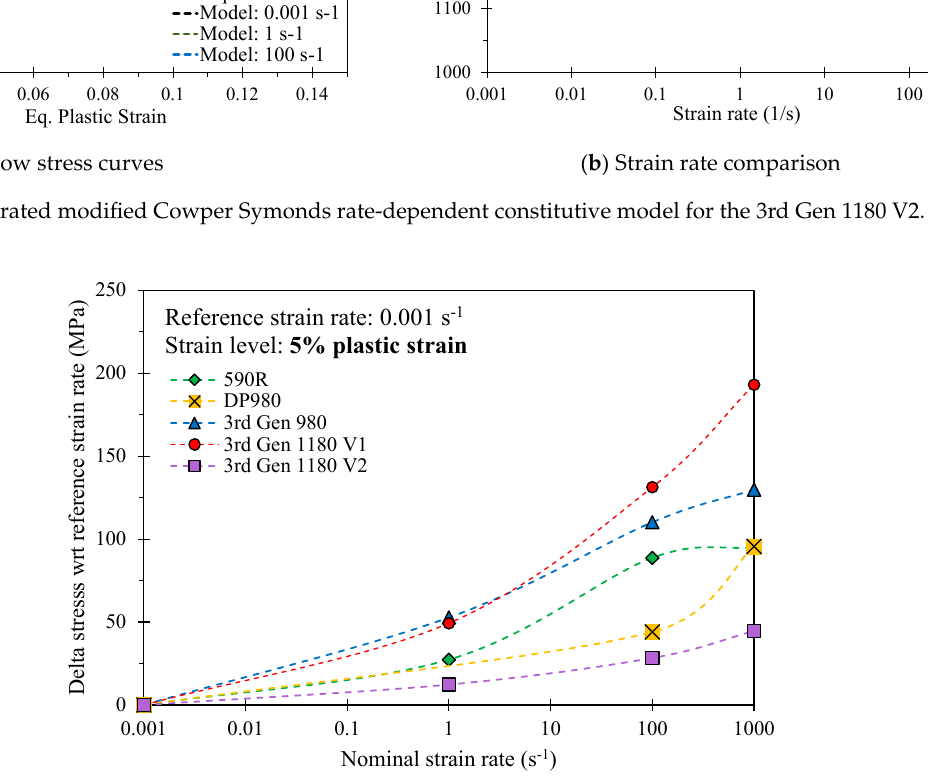
Materials 2021 , 14 , x FOR PEER REVIEW 16 of 39